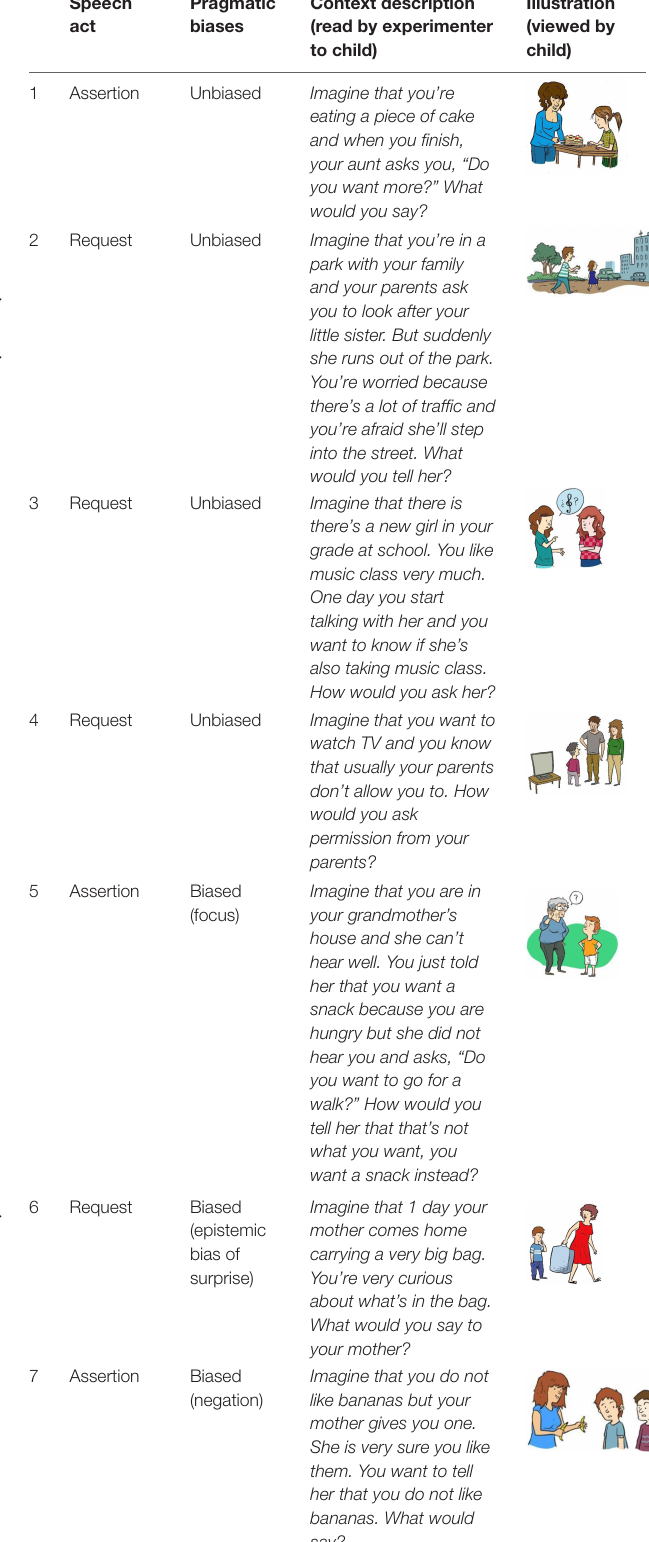
TABLE 1 | Speech acts tested by the APT, with sample prompt context descriptions and corresponding illustrations. Speech